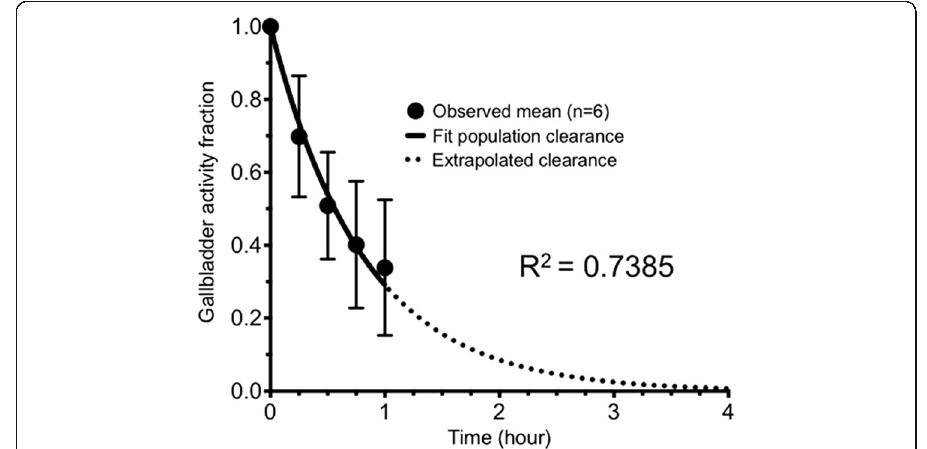
Fig. 1 Population gallbladder clearance curve for healthy adults with standard deviation error